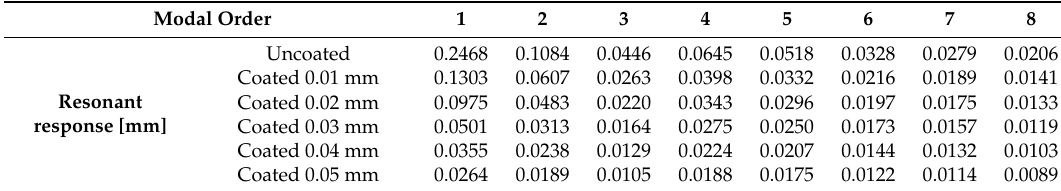
Table 10. The influence of thickness of hard coating on the resonant response of the composite